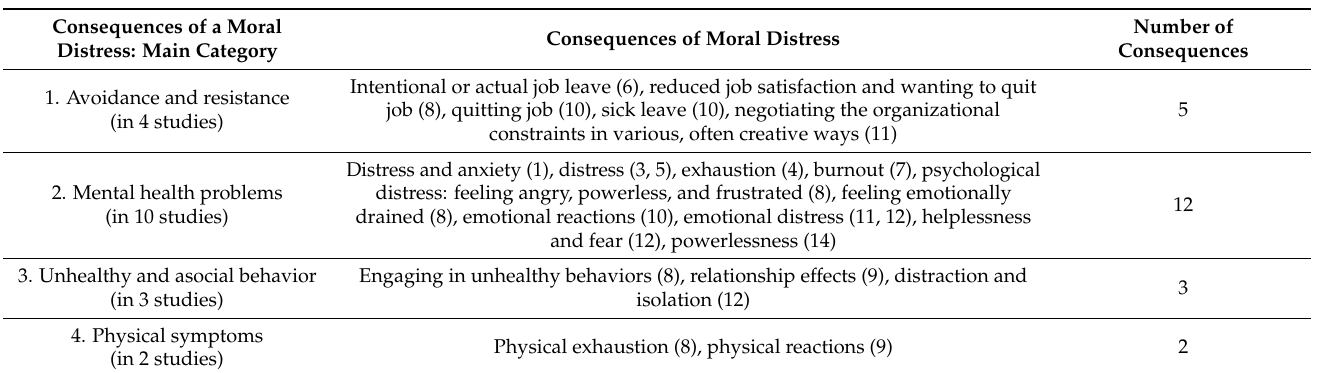
Table 3. Consequences of moral distress and their categorizations identified in the included studies. Each study is indicated using study numbers in Table 1.